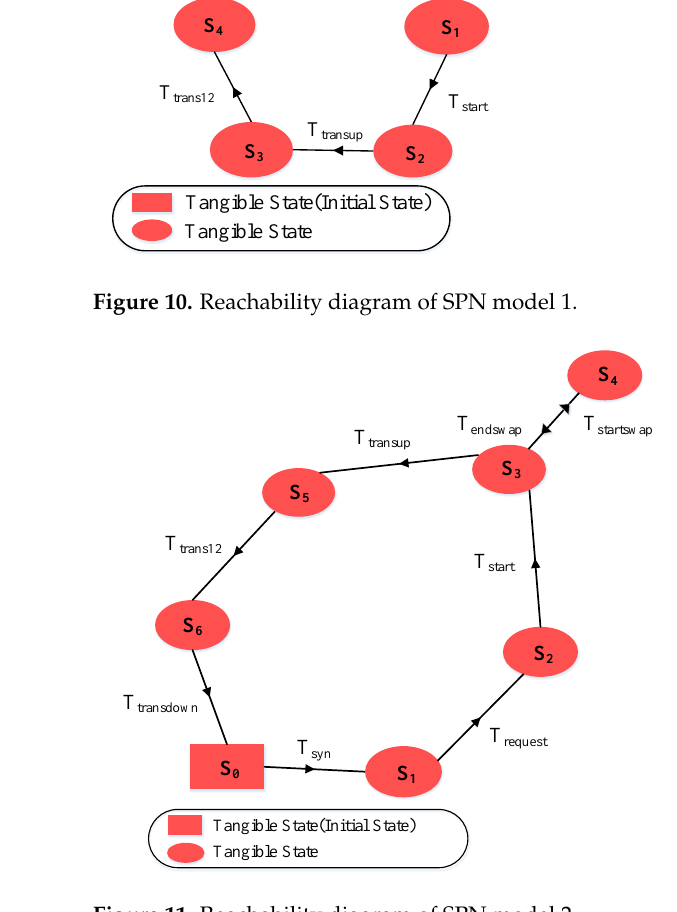
Figure 11. Reachability diagram of SPN model 2. Table 7. Steady-state probabilities of each marking.